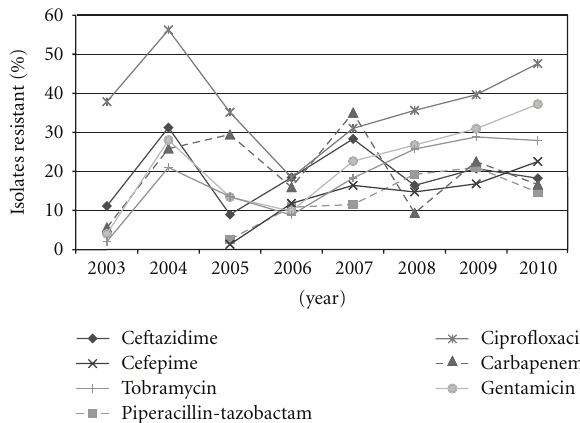
Figure 1: Percent of intensive care unit P. aeruginosa isolates resis- tant to various anti-pseudomonal